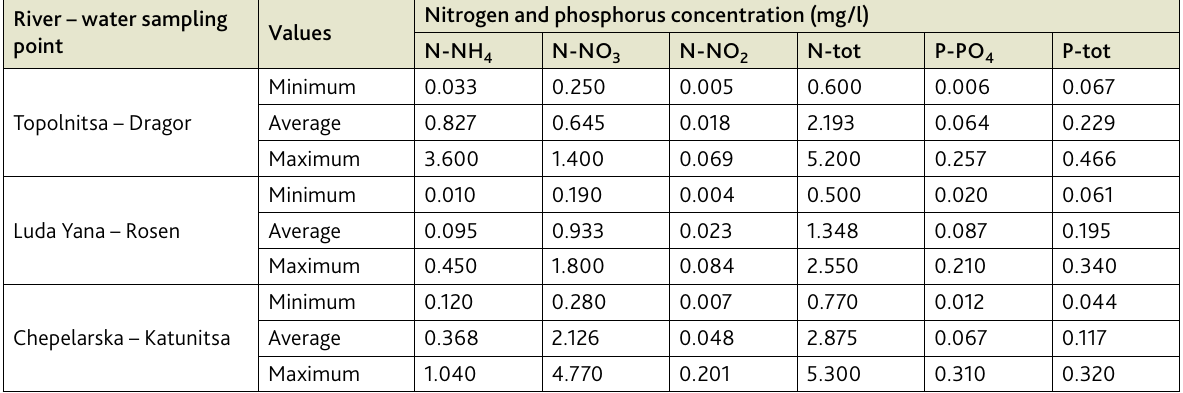
Table 5. Descriptive statistics of the nitrogen and phosphorus concentration (mg/l) in surface waters River – water sampling point Topolnitsa –